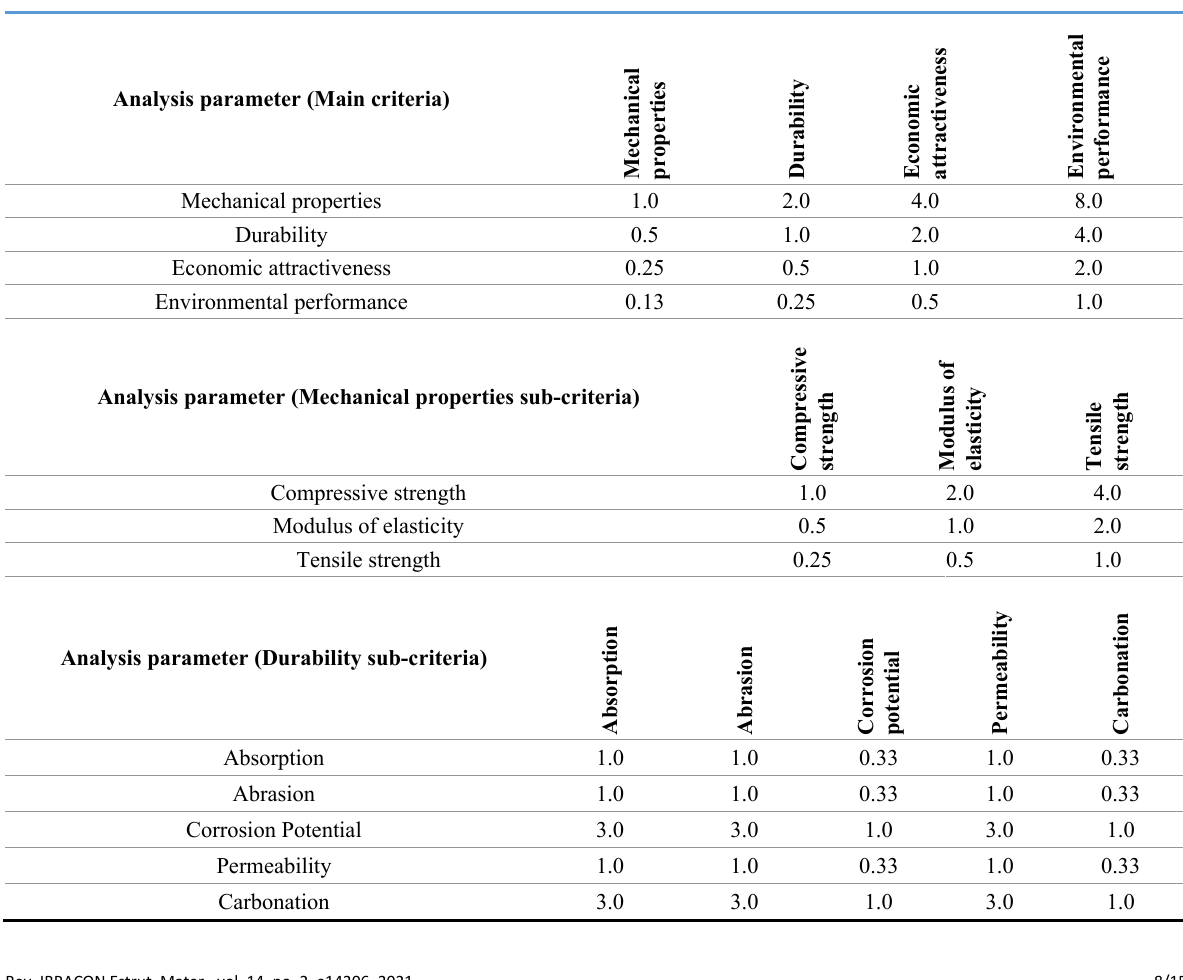
Table 5. Decision matrix of criteria, mechanical properties sub-criteria and durability sub-criteria (Scenario 2 - building structure).